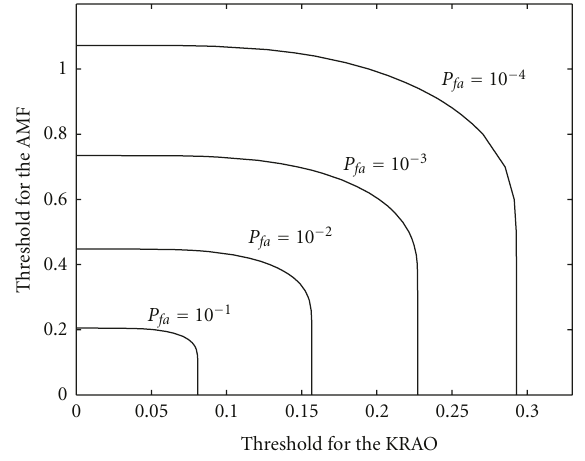
Figure 6: Contours of constant P fa for the KRAO-ASB with N = 8, K = 24, and ρ = 1 . 2.